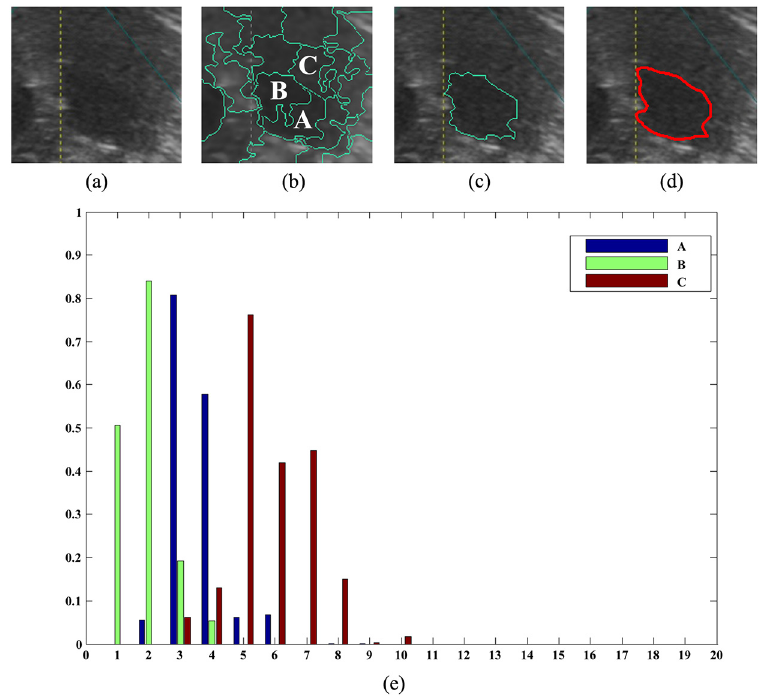
Fig 11. An example of a tumor with weak boundaries. (a) The original image. (b) Superpixels. Superpixels A and B are inside the tumor, while superpixel C is outside. (c) The boundary generated by the proposed method. (d) Standard boundary. (e) Histograms for three superpixels A, B, and C.